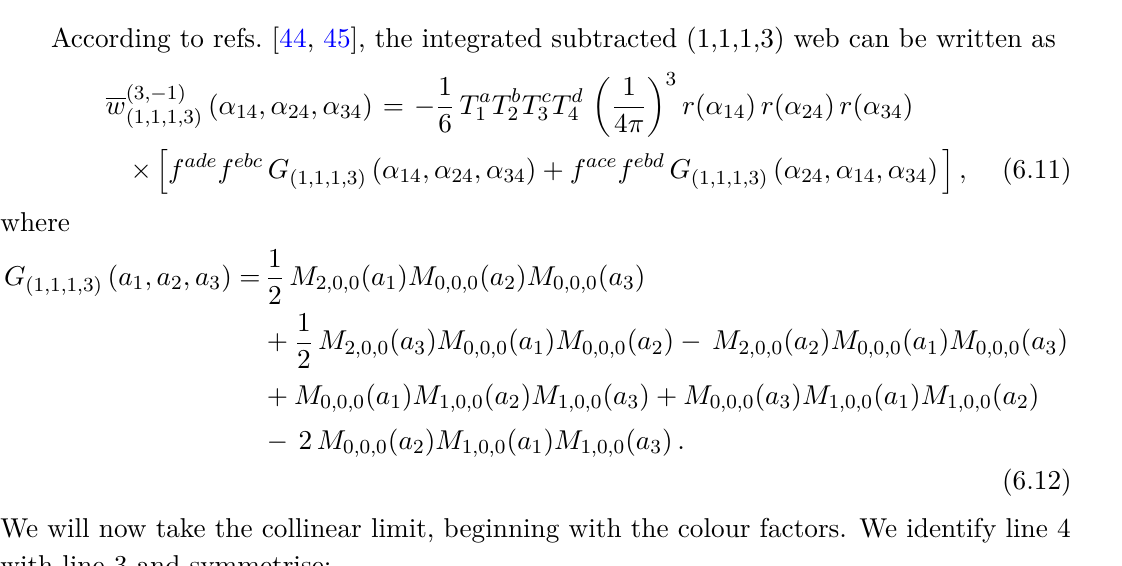
Figure 13 . Two different (1,1,1,3)-type webs w 1113 ( α 14 , α 24 , α 34 ) (top left) and w 1113 ( α 13 , α 23 , α 34 ) (top right), give a contribution to the (1,1,4) web in the limit that lines 3 and 4 are collinear. The red dashed circle indicates the symmetric contribution will be